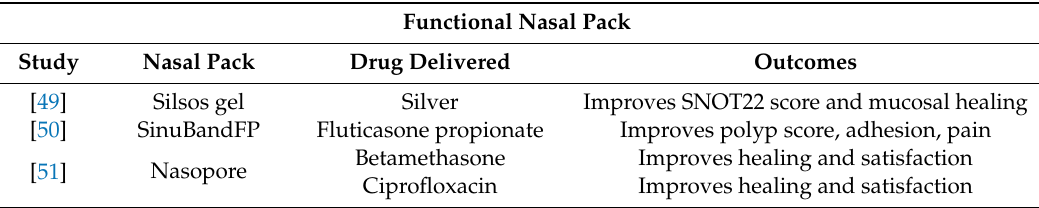
Table 2. Functional nasal pack for drug